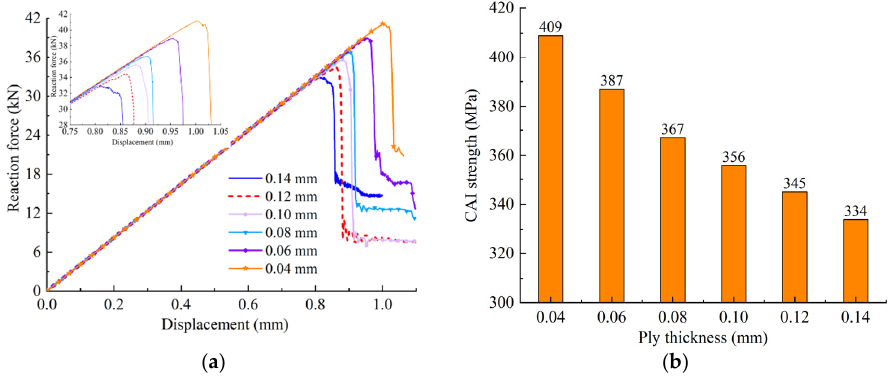
Figure 18. Compressive responses with different ply thicknesses. ( a ) Reaction force curve. ( b ) CAI strength with different ply thicknesses.